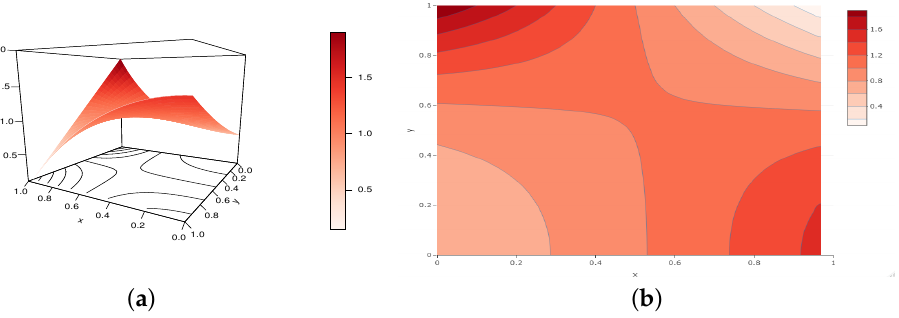
Figure 14. Illustrations of the ( a ) perspective plot and ( b ) contour plot of the TGCC copula